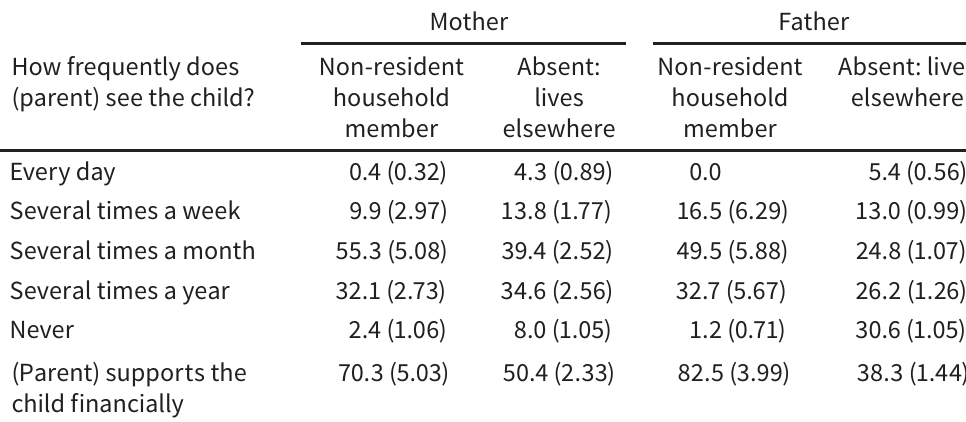
Parental contact and financial support to children